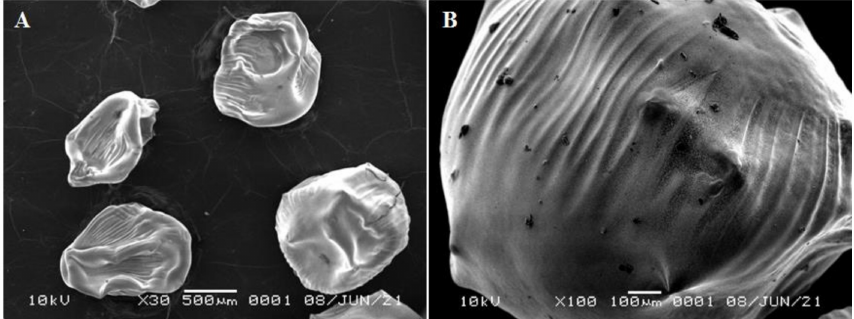
Figure 6. SEM spectrum of AgNP-chi-spheres using 20% NaOH, ( A ) 30 × ; ( B ) 100 × .